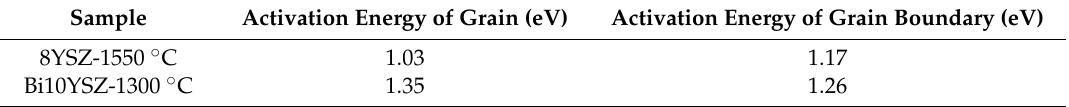
Table 3. Activation energies of grain and grain boundary of 8YSZ and